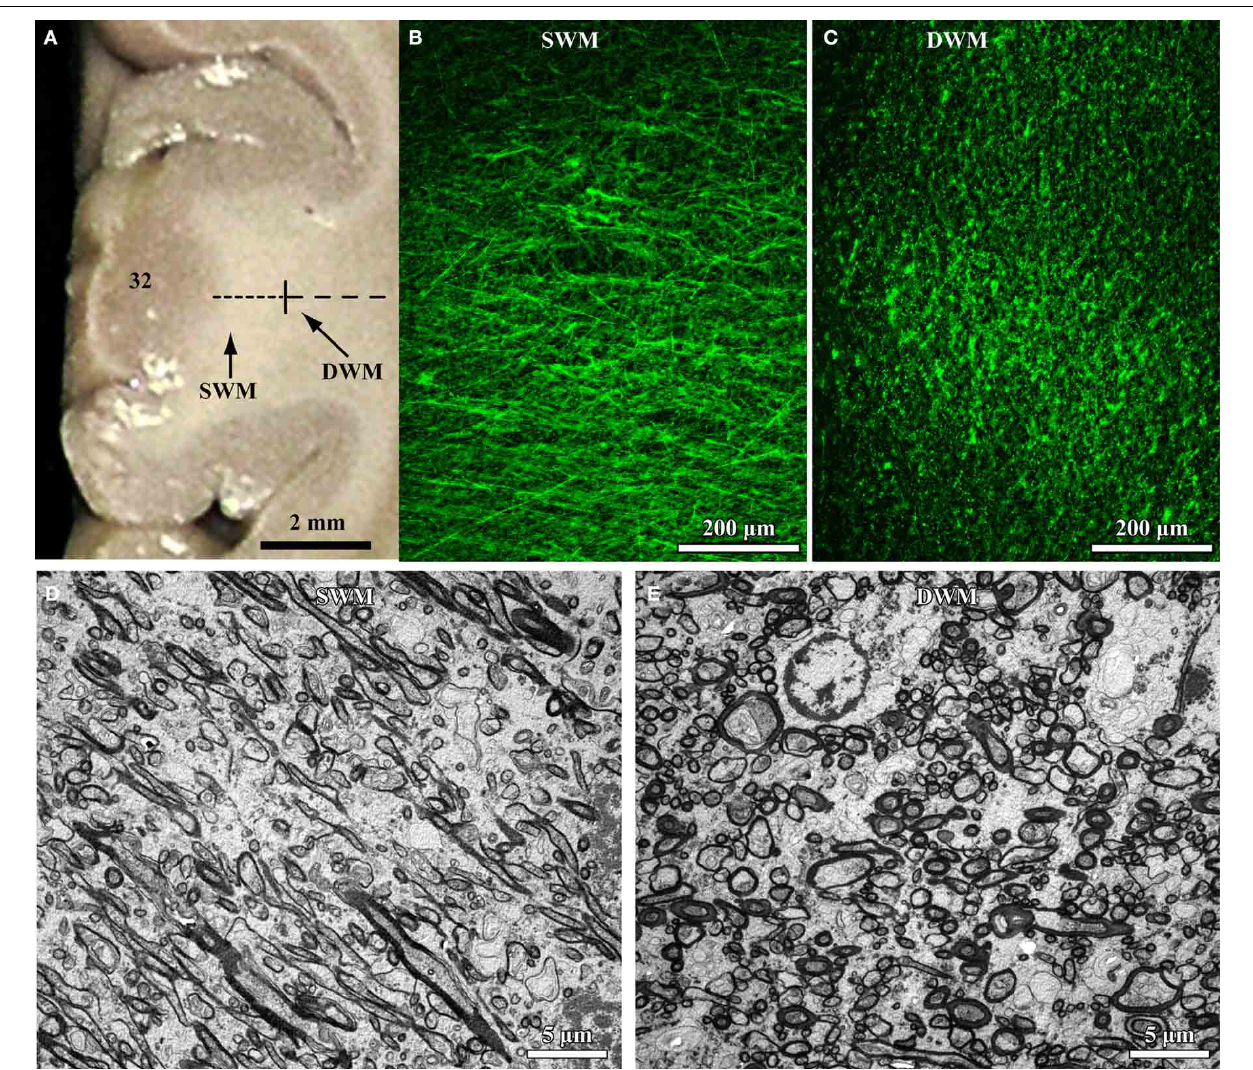
FIGURE 1 | High resolution segmentation of the white matter. (A) Coronal view of a representative ACC (A32) tissue slab. Dotted lines indicate gross (macroscopic) distinction of superficial (SWM) and deep (DWM) white matter, based on subsequent microscopic analysis. (B,C) Fluorescent photomicrographs of coronal sections from A32 white matter after labeling of axons with a neurofilament protein antibody (NFP-200; green). Light microscopic segmentation of superficial (B) and deep (C) white matter is based on the distinct orientation of axons at